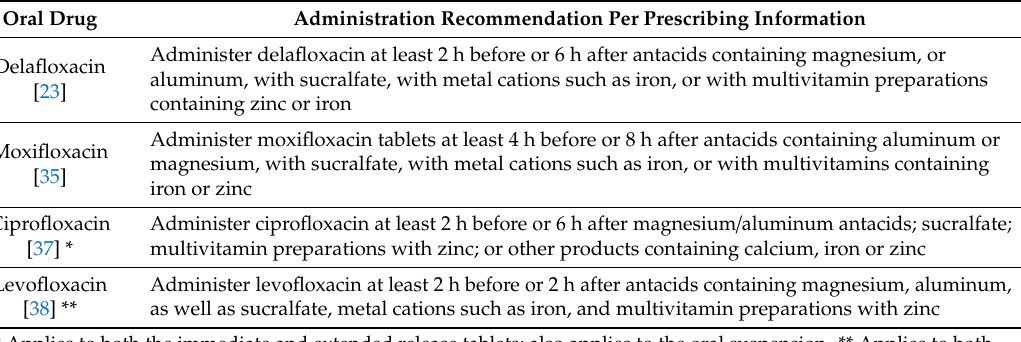
Table 3. Manufacturer-recommendation dose